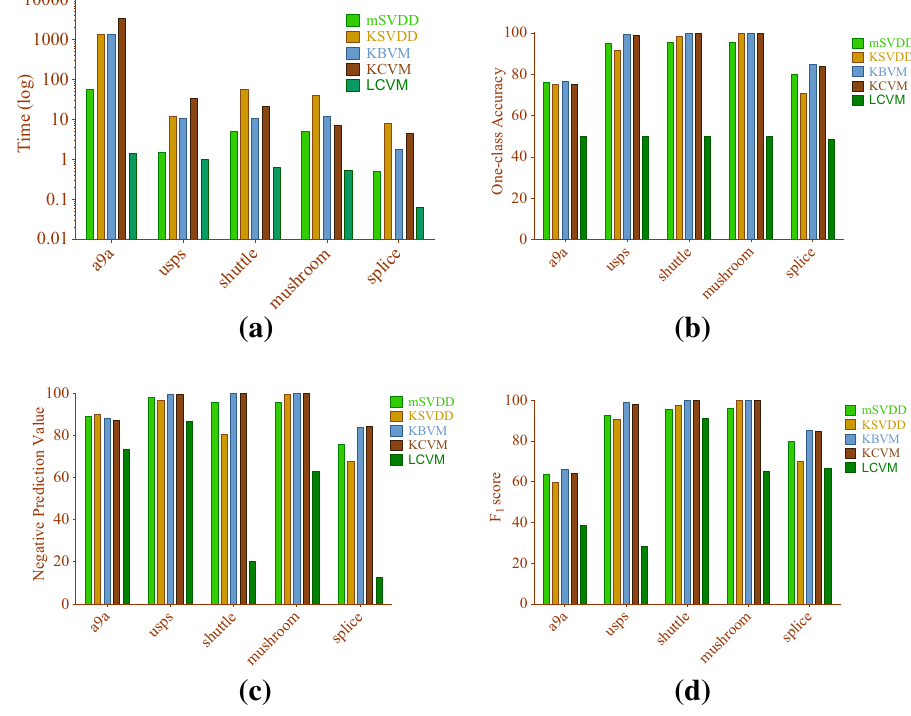
Fig. 3 Experimental results on the datasets. a Training times, b One-class accuracy, c negative prediction value, d F 1